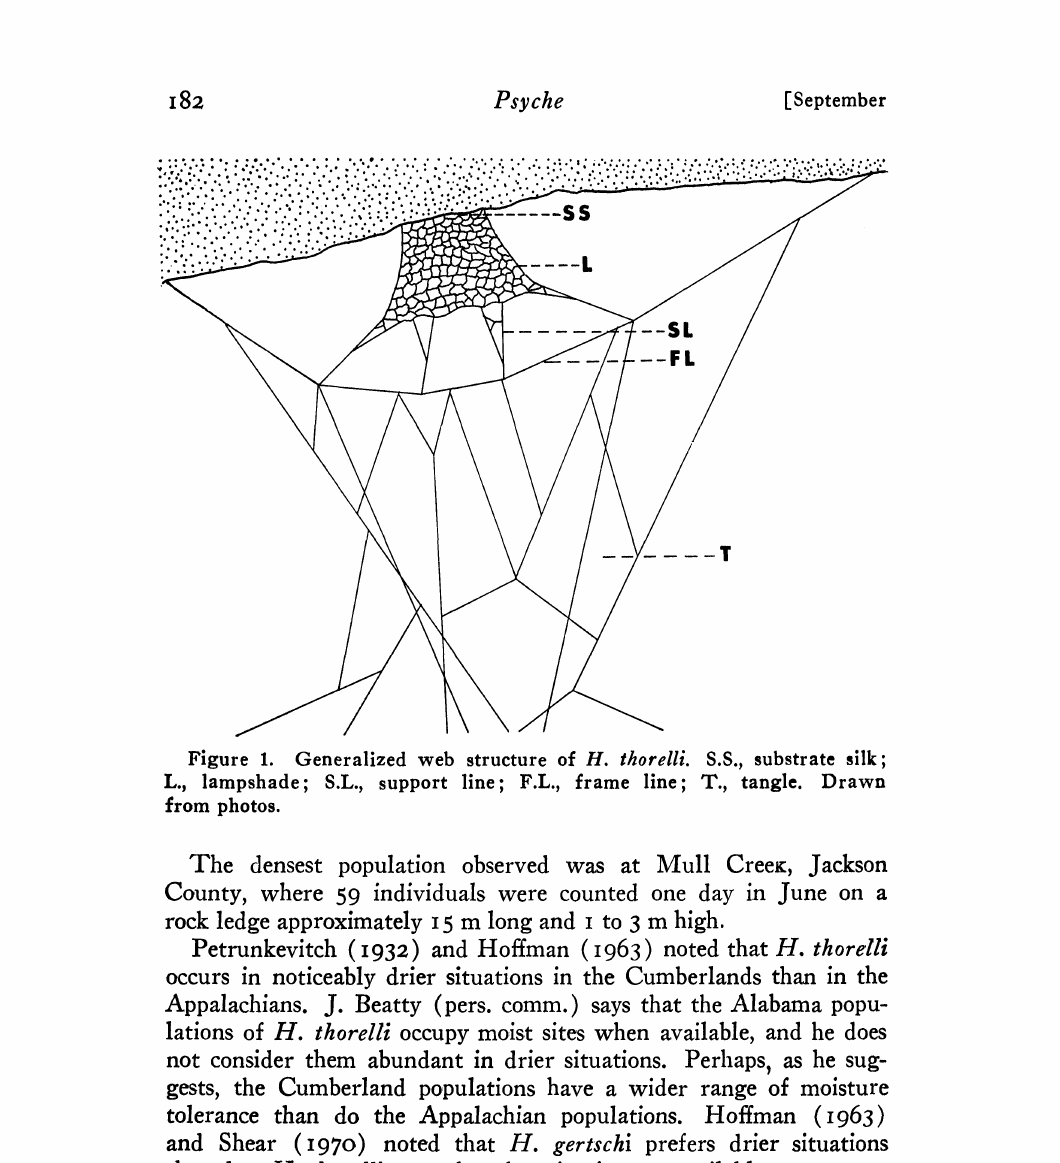
Figure 1. Generalized web structure of H. thorelli. S.S., substrate silk; L., lampshade; S.L., support line; F.L., frame line; T., tangle. Drawn from